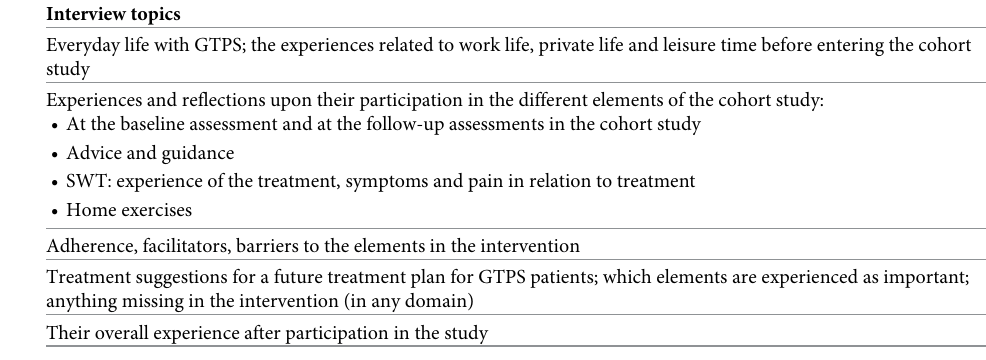
Table 1. Topics included in the interview